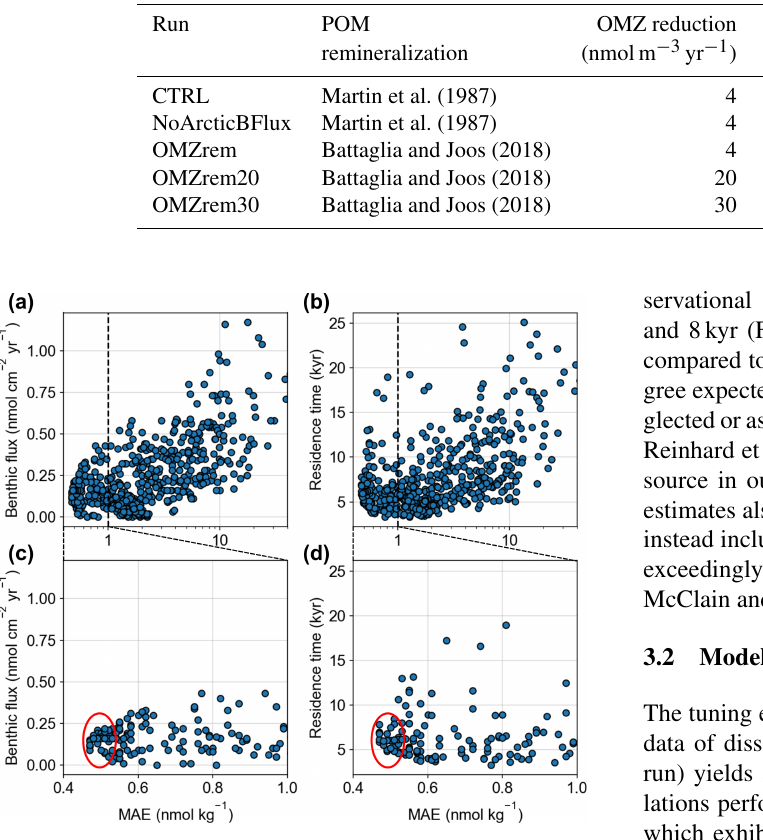
Figure 2. (a, c) Model performance of the tuning ensemble (cal- culated with the cost function of the mean absolute error, MAE – the smaller the better) dependent on the benthic flux and (b, d) the diagnosed mean residence time of dissolved Cr. Note the logarith- mic x axes in (a, b) . (c, d) are zoom-ins of (a) and (b) and with linear x axes. Red ellipses indicate the simulations that best fit the observational